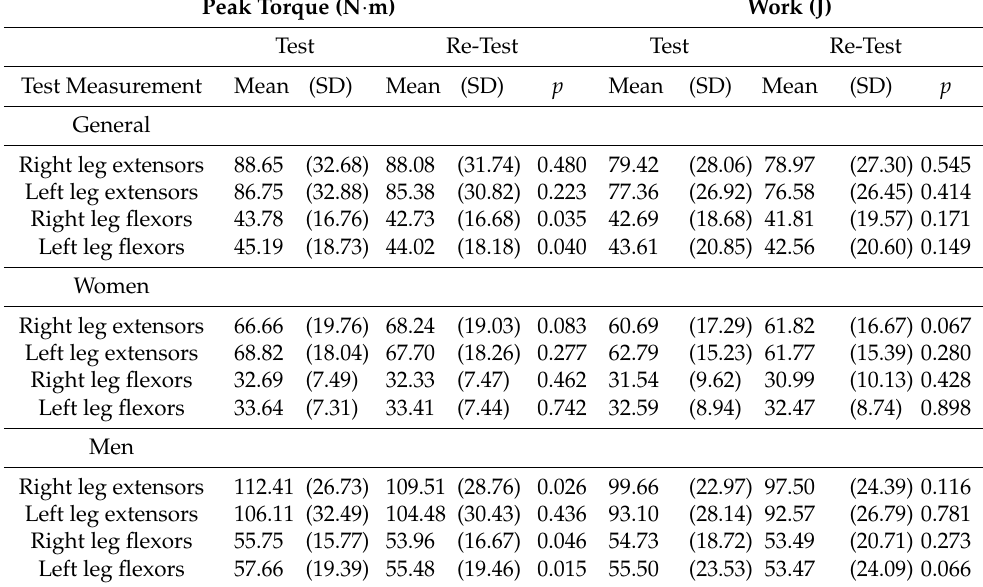
Table 2. Summary of Isokinetic Peak Torque and